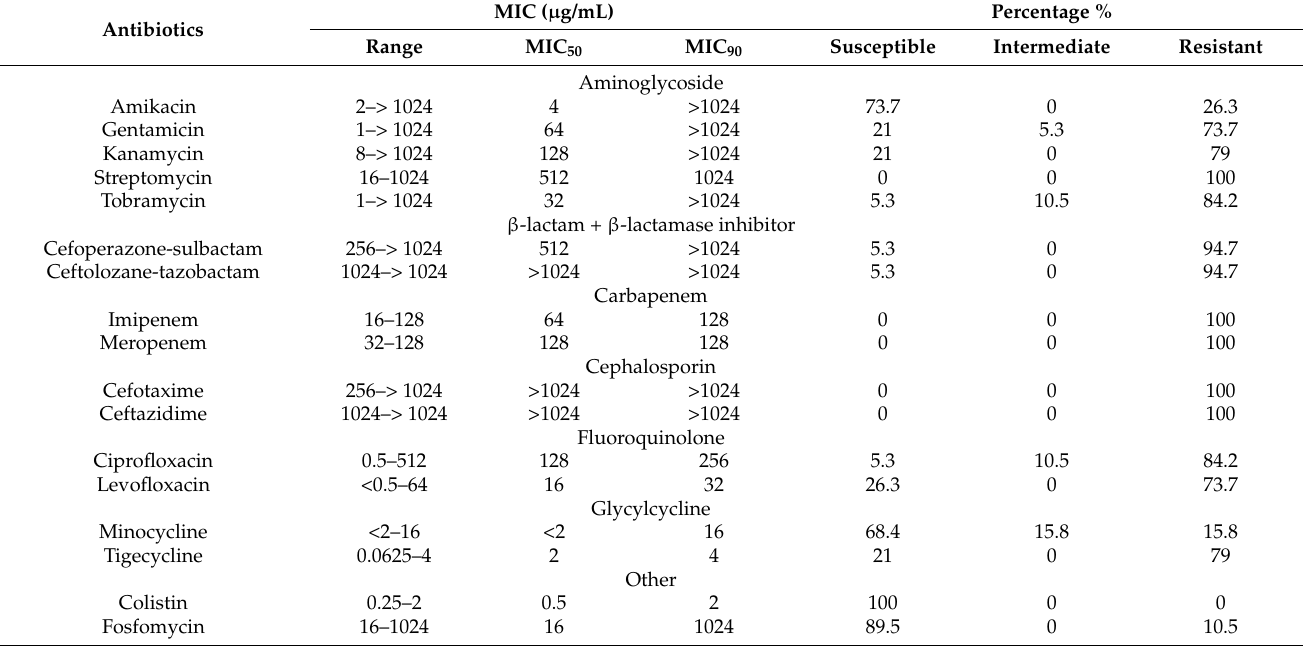
Table 1. Summary of antimicrobial susceptibility of 19 carbapenem-resistant isolates.